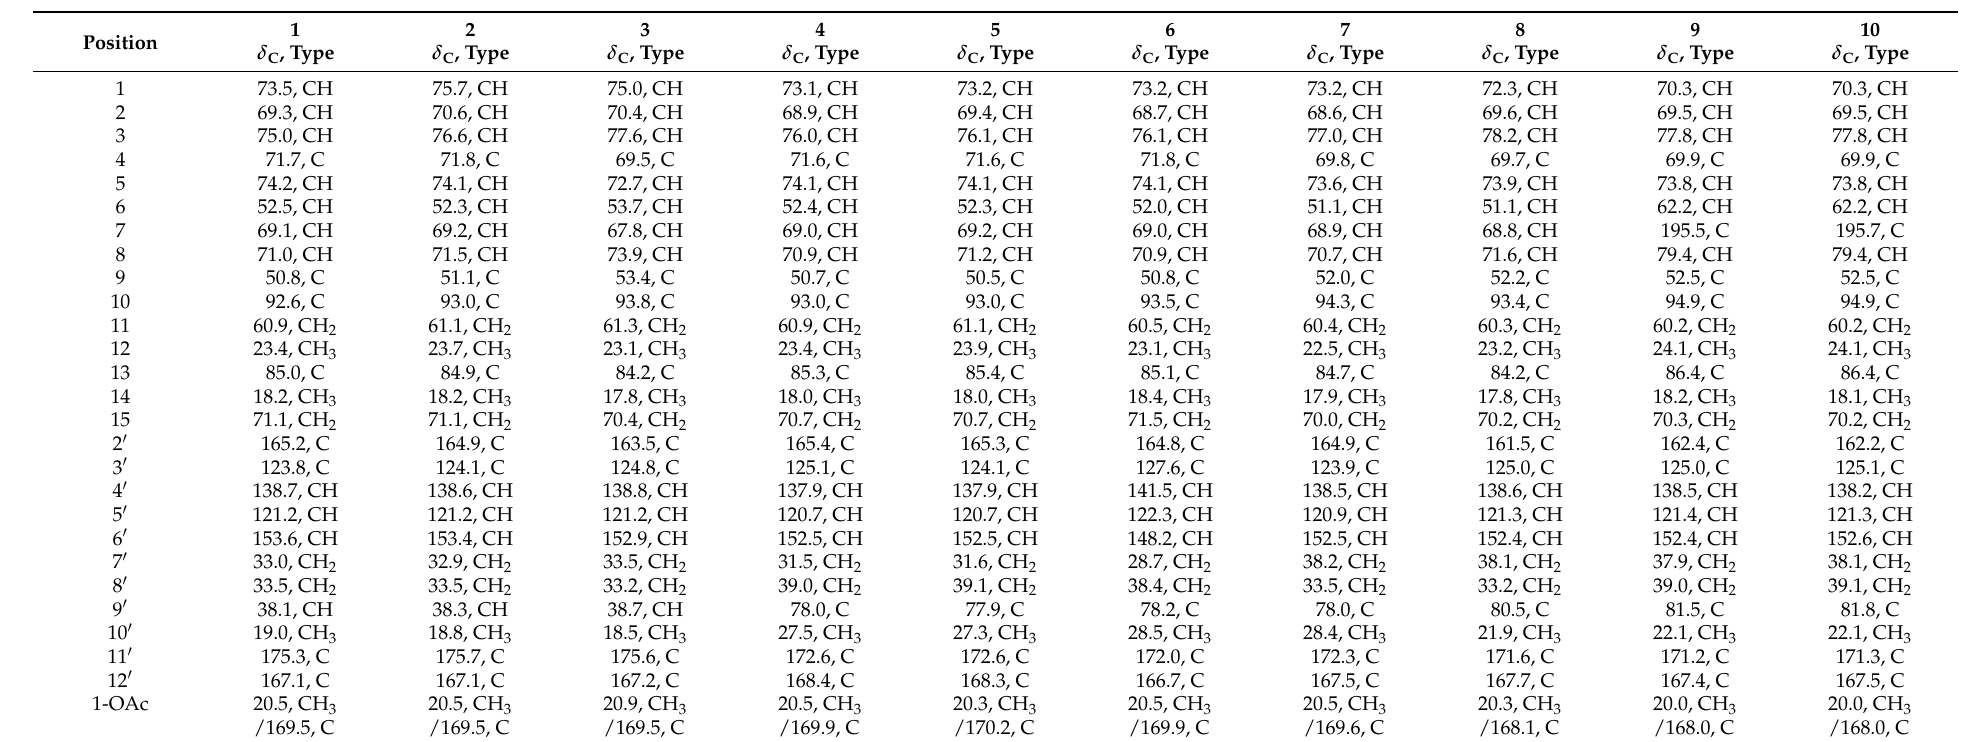
Table 2. 13 C-NMR spectroscopic data for compounds 1 – 10 (150 MHz, CDCl 3